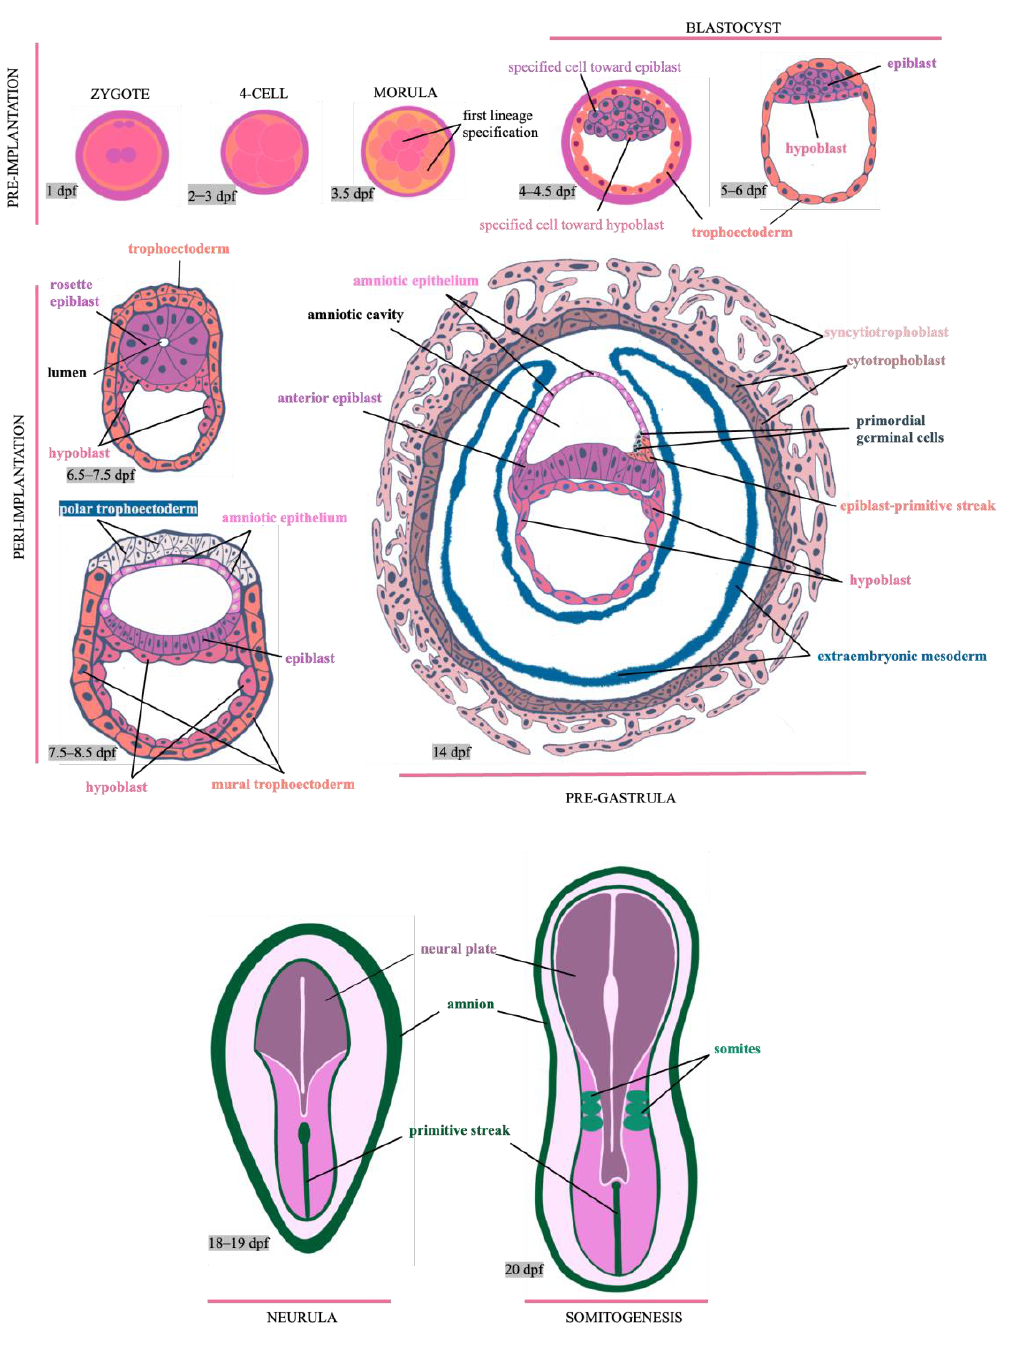
Figure 1. Critical events in early human development. The days post-fertilization (dpf) are an approximation of each embryonic event. One dpf: single cell-zygote stage, with polar bodies. 2–3 dpf: activation of the zygotic genome. 3.5 dpf: morula compaction and first lineage specification (toward trophectoderm and inner cell mass). 4.0–4.5 dpf: early blastocyst containing the outer cells (trophectoderm) (salmon color) and inner cell mass, from which the epiblast (prickly purple color) and hypoblast (shadow azalea pink color) begin to segregate (second lineage specification). 5.0–6.0 dpf: the epiblast (prickly purple color) and hypoblast (shadow azalea pink color) lineages are established. 6.5–7.5 dpf: the start of amniogenesis, where the epiblast (prickly purple color) is